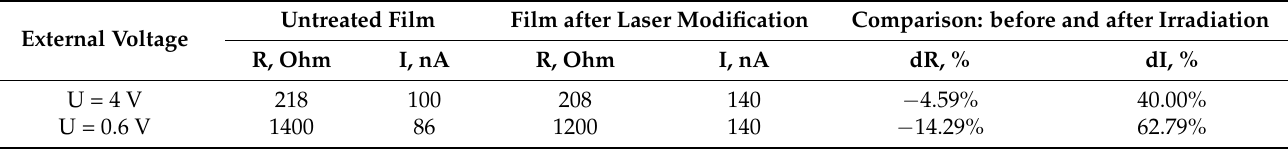
Table 1. Electrical characteristics of PbSe